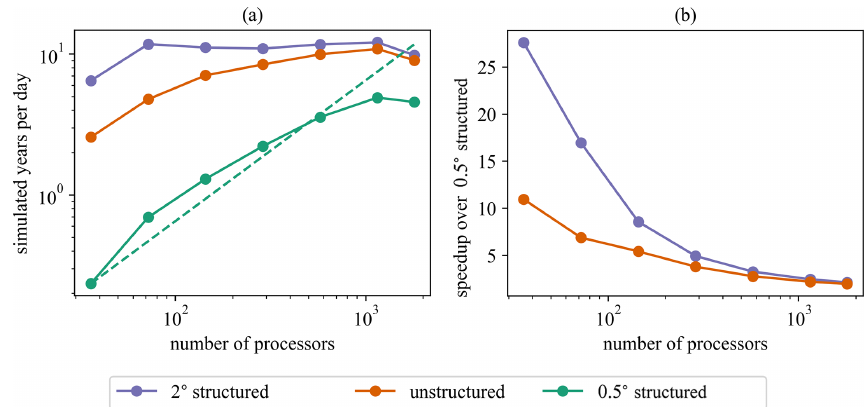
Figure 13. (a) Throughput in terms of simulated years per day based off a 1-month simulation with each mesh. The dashed line represents ideal scaling for the 0.5 ◦ structured grid. (b) Speedup for the unstructured and 2 ◦ meshes over the 0.5 ◦ structured grid for each core